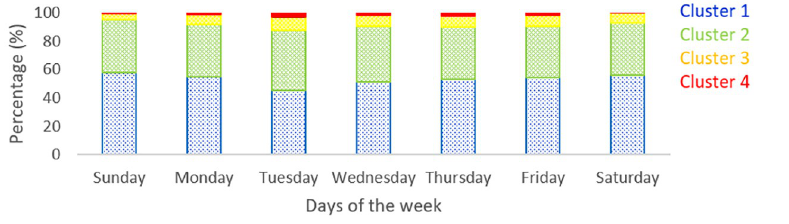
Fig 7. Proportion of memberships of clusters on each day of the week.